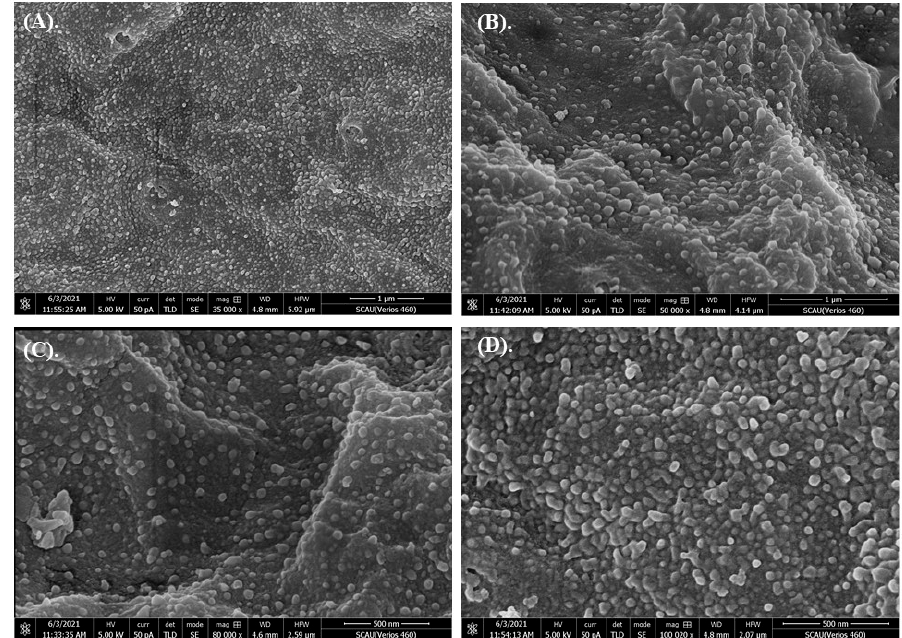
Figure 1. High-definition enlarged images of chorion membranes of grass carp. ( A – D ) show different parts of chorion membranes.